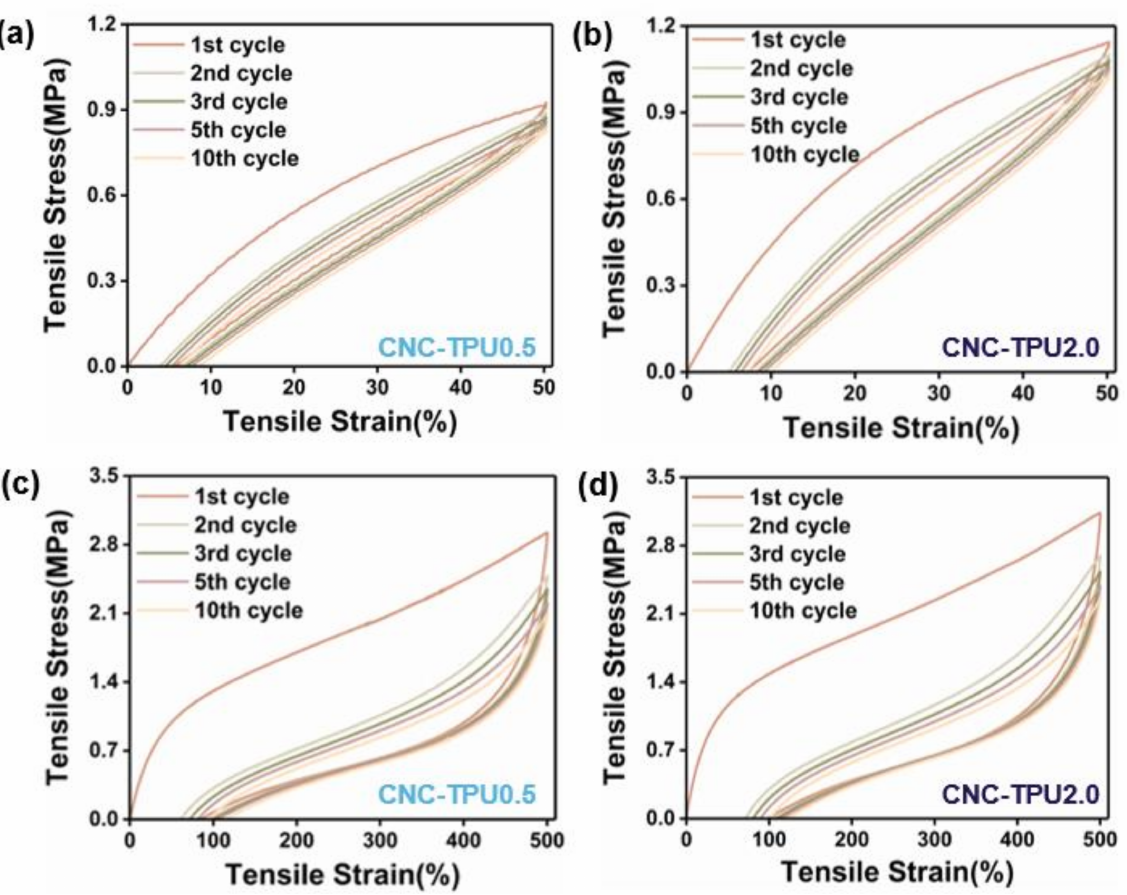
Figure A2. Stress–strain curves of CNC-TPU 0.5 and CNC-TPU 2.0 composite films under cyclic loading at 50% and 500% strain.